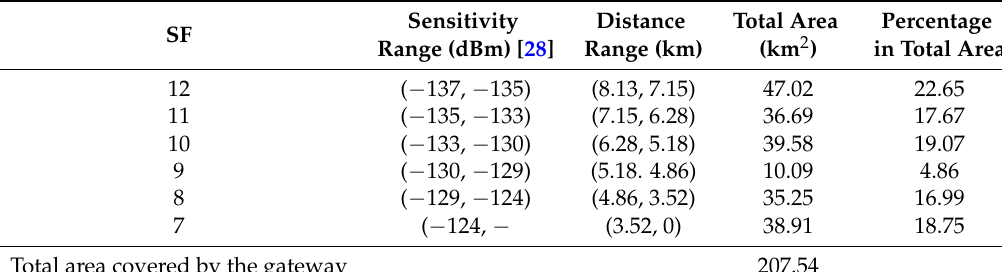
Table 7. Area covered by each spreading factor using the Okumura propagation